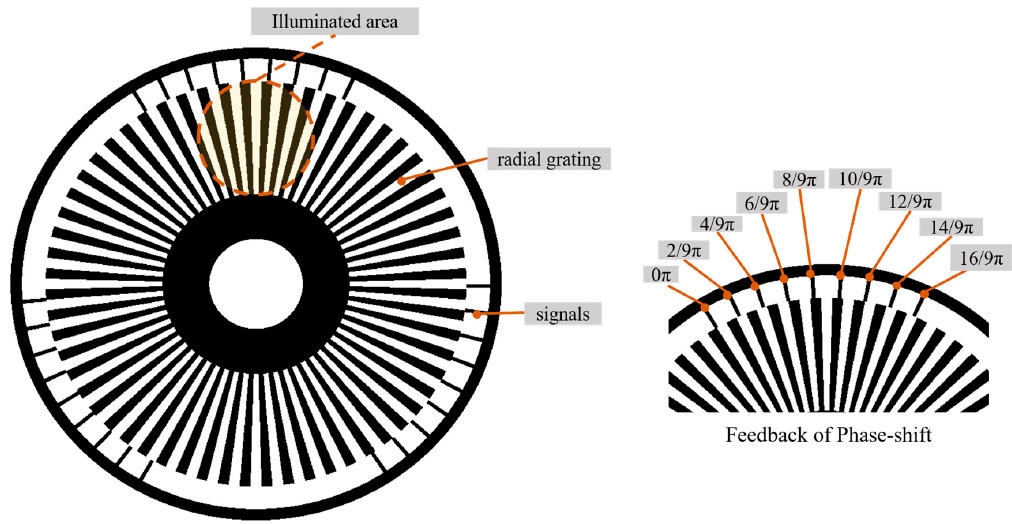
Figure 2. Schematic diagram of self-made grating disc design.